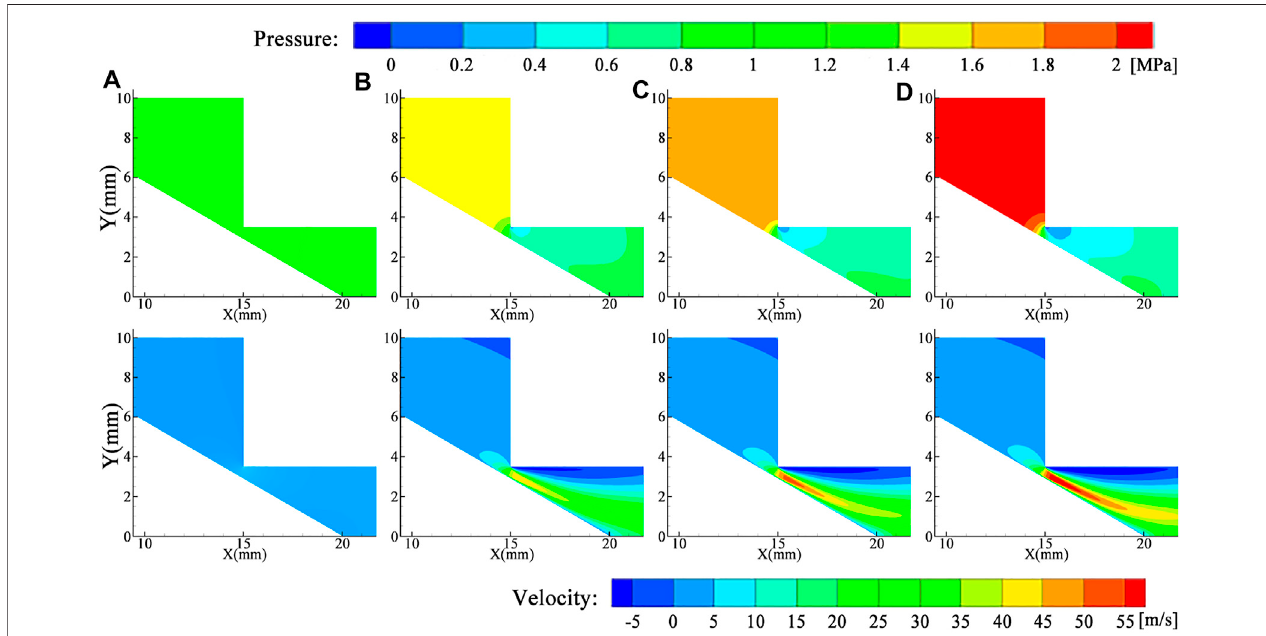
FIGURE 8 | Pressure and velocity nephogram with different pressure differentials: (A) Δ p = 0.5 MPa; (B) Δ p = 0.8 MPa; (C) Δ p = 1.1 MPa; (D) Δ p = 1. 4 MPa.